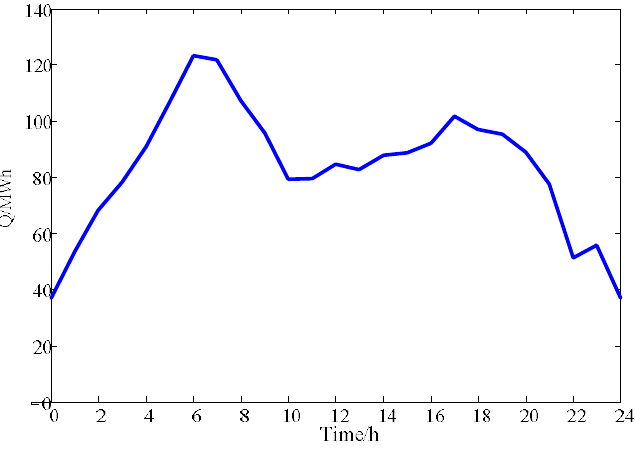
Figure 11. Energy storage in the centralized charging station.